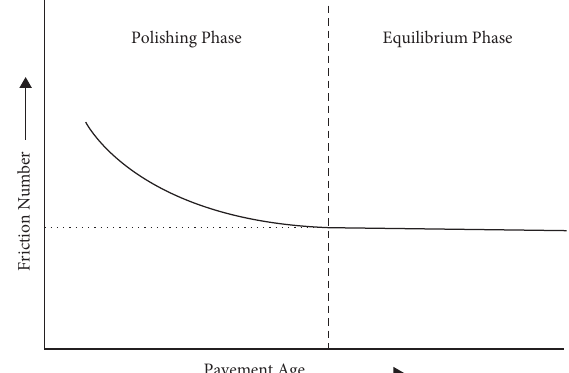
Figure 4: Decrease of pavement skid resistance due to the polishing of traffic [60].